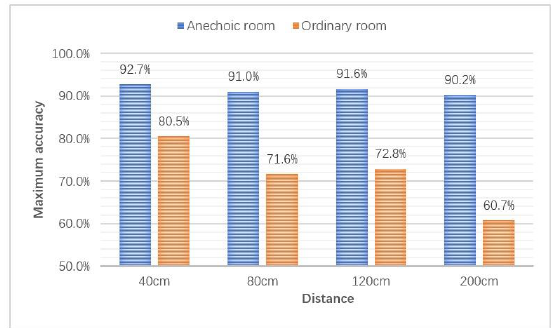
Figure 9: Recognition results in different indoor environments based on raw data